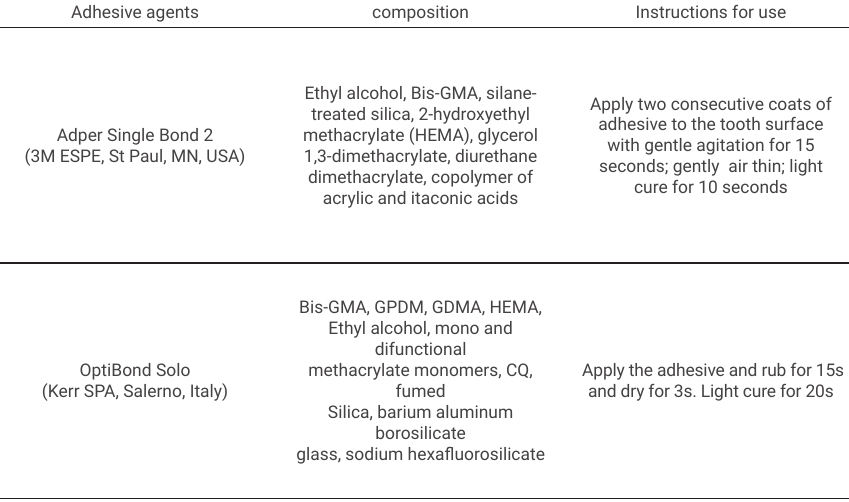
Table 1. composition and instruction of adhesive system used in the